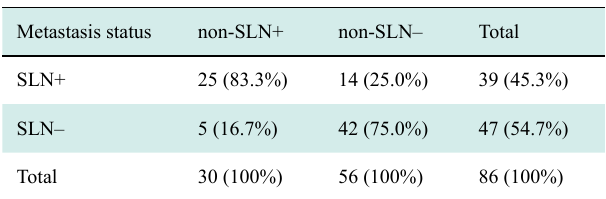
Table 2 Diagnostic value of SLNB guided by TLCEUS/fixed-point dye injection method Metastasis